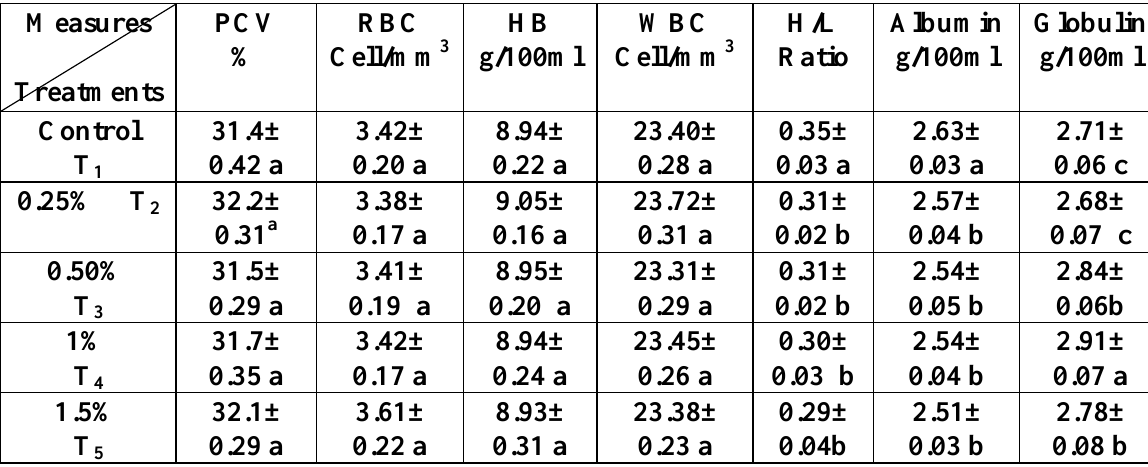
Table (3) Effect of turmeric (Curcuma longa) on mortality , Dressing %,liver %,gizzard% and heart% of broiler ± SE. abc, Means in the same Colum with no common superscript differ significantly ,